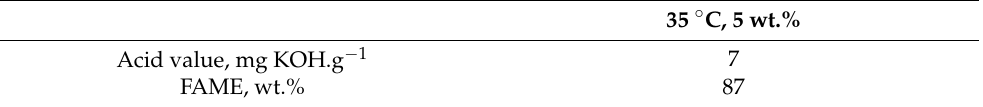
Table 5. Characteristics of the product obtained after heterogenous esterification of RBO.